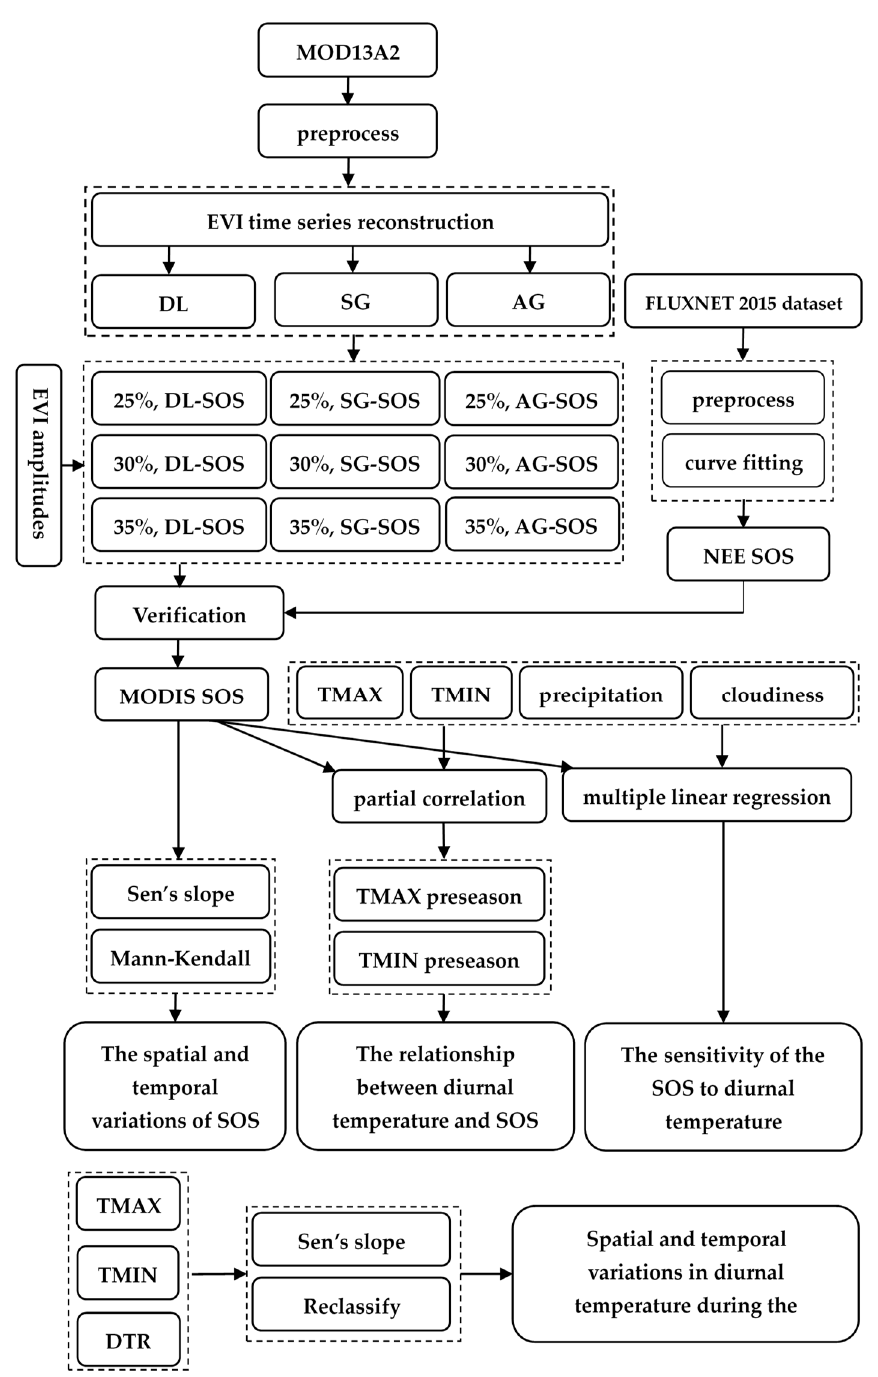
Figure 1. The flowchart of this study. The acronyms in the figure are as follows: SOS (start of the season); DL (double logistic); SG (Savitzky–Golay filter); AG (asymmetric Gaussian); NEE (net ecosystem exchange); EVI (enhanced vegetation index); TMAX (daytime maximum temperature); TMIN (nighttime minimum TMIN (nighttime minimum temperature); DTR (diurnal temperature temperature); DTR (diurnal temperature range).